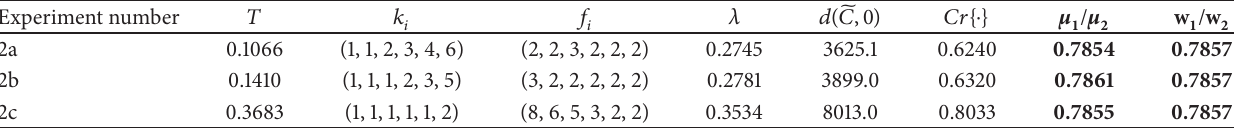
Table 5: Results for Experiment 2 using IDE.